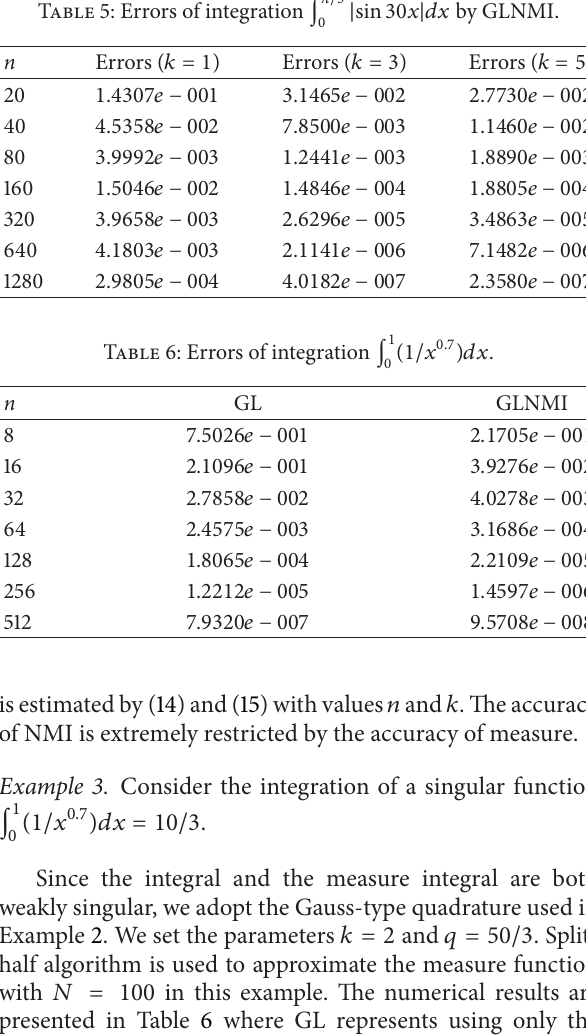
Table 3: Errors of integration ∫